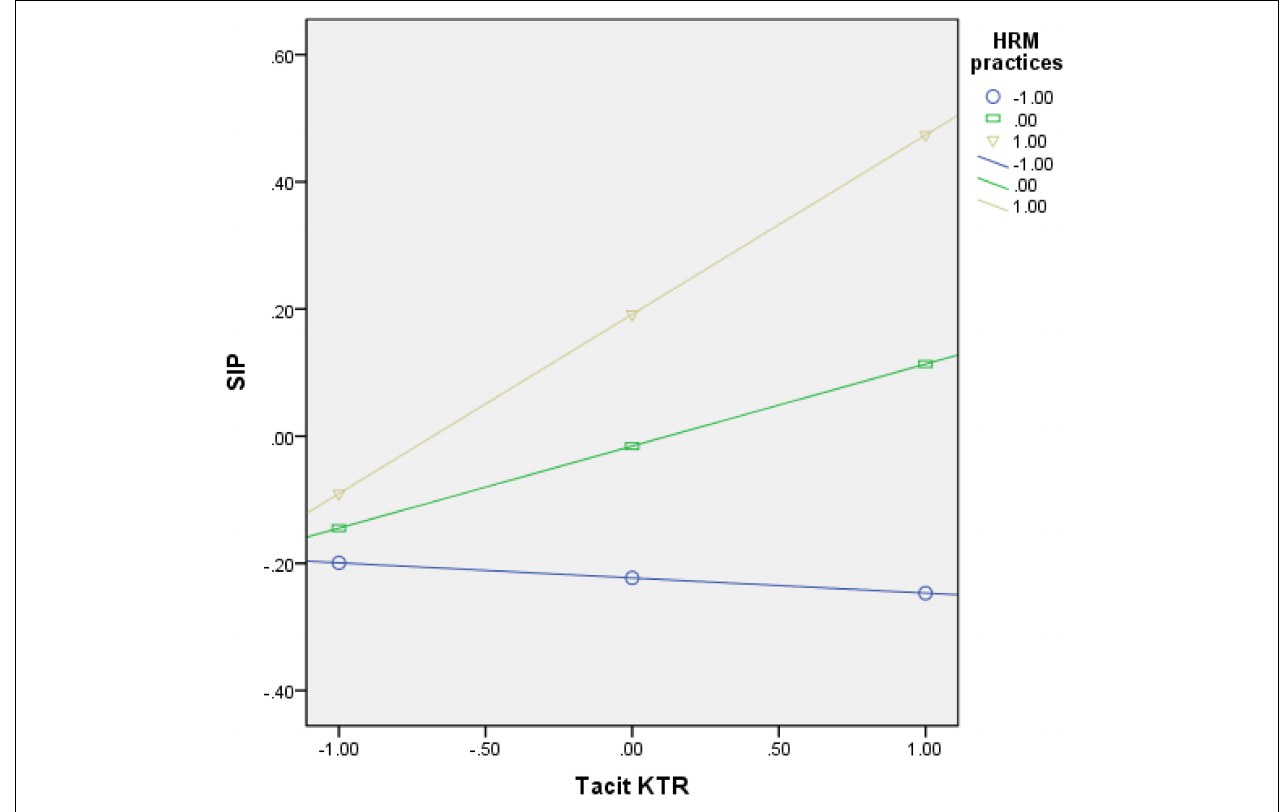
FIGURE 2 | The moderating effects of HRM Practices on the impact of tacit KTR and SIP.